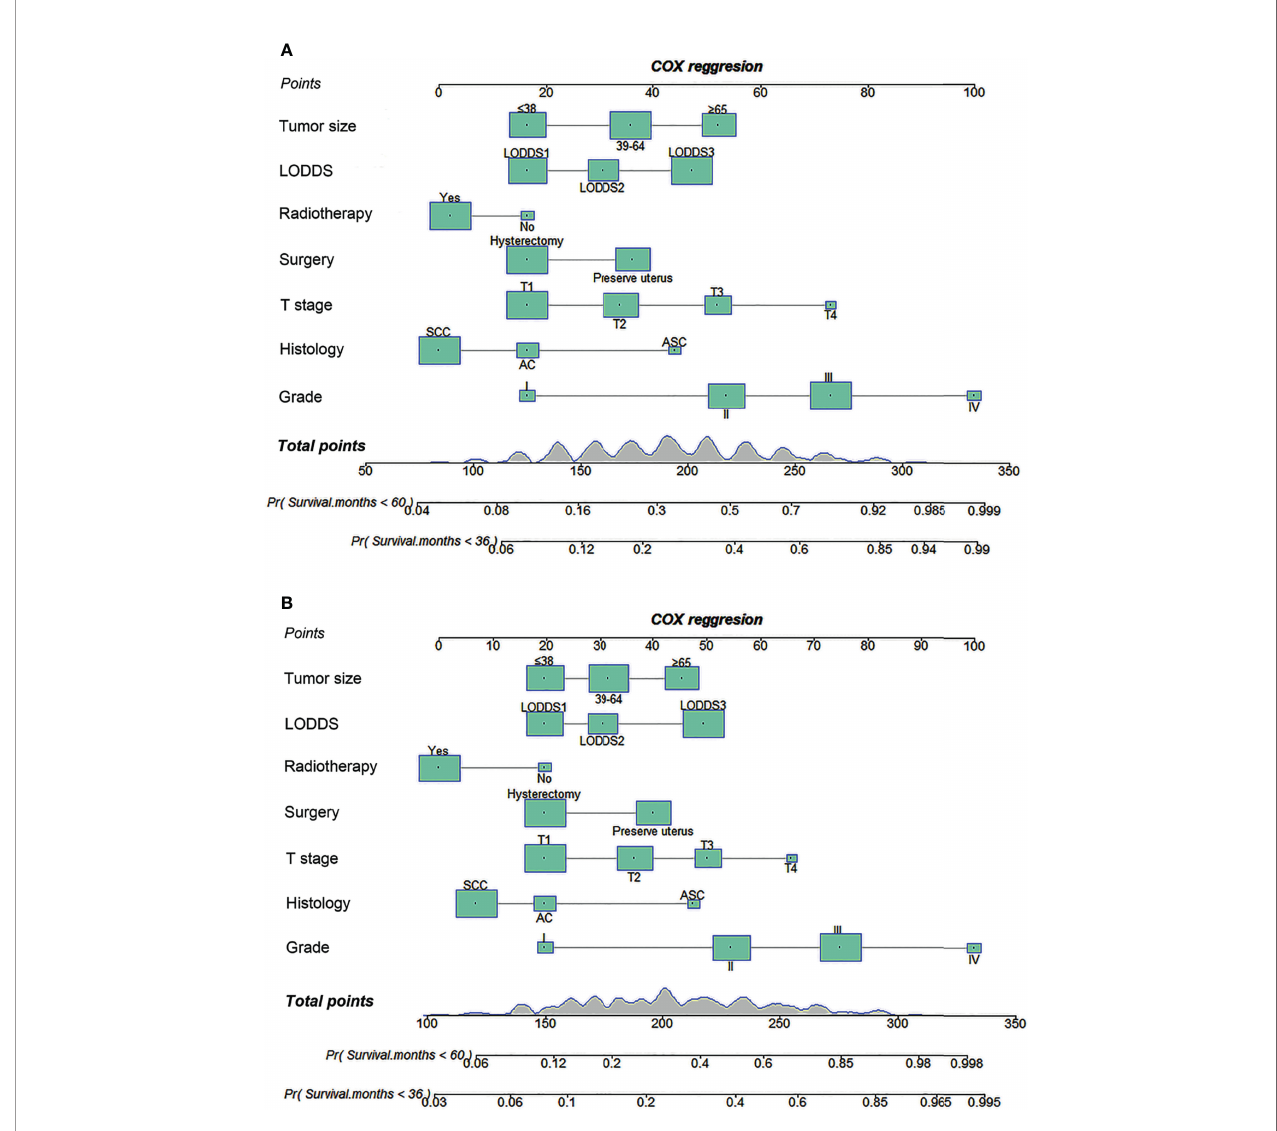
FIGURE 3 | Nomograms for predicting 3- and 5-year OS (A) and CSS (B) in cervical cancer patients with lymph node metastasis. OS, overall survival; CSS, cancer- speci fi c survival; LODDS, log odds of positive lymph nodes; SCC, squamous cell carcinoma; AC, adenocarcinoma; ASC, adenosquamous